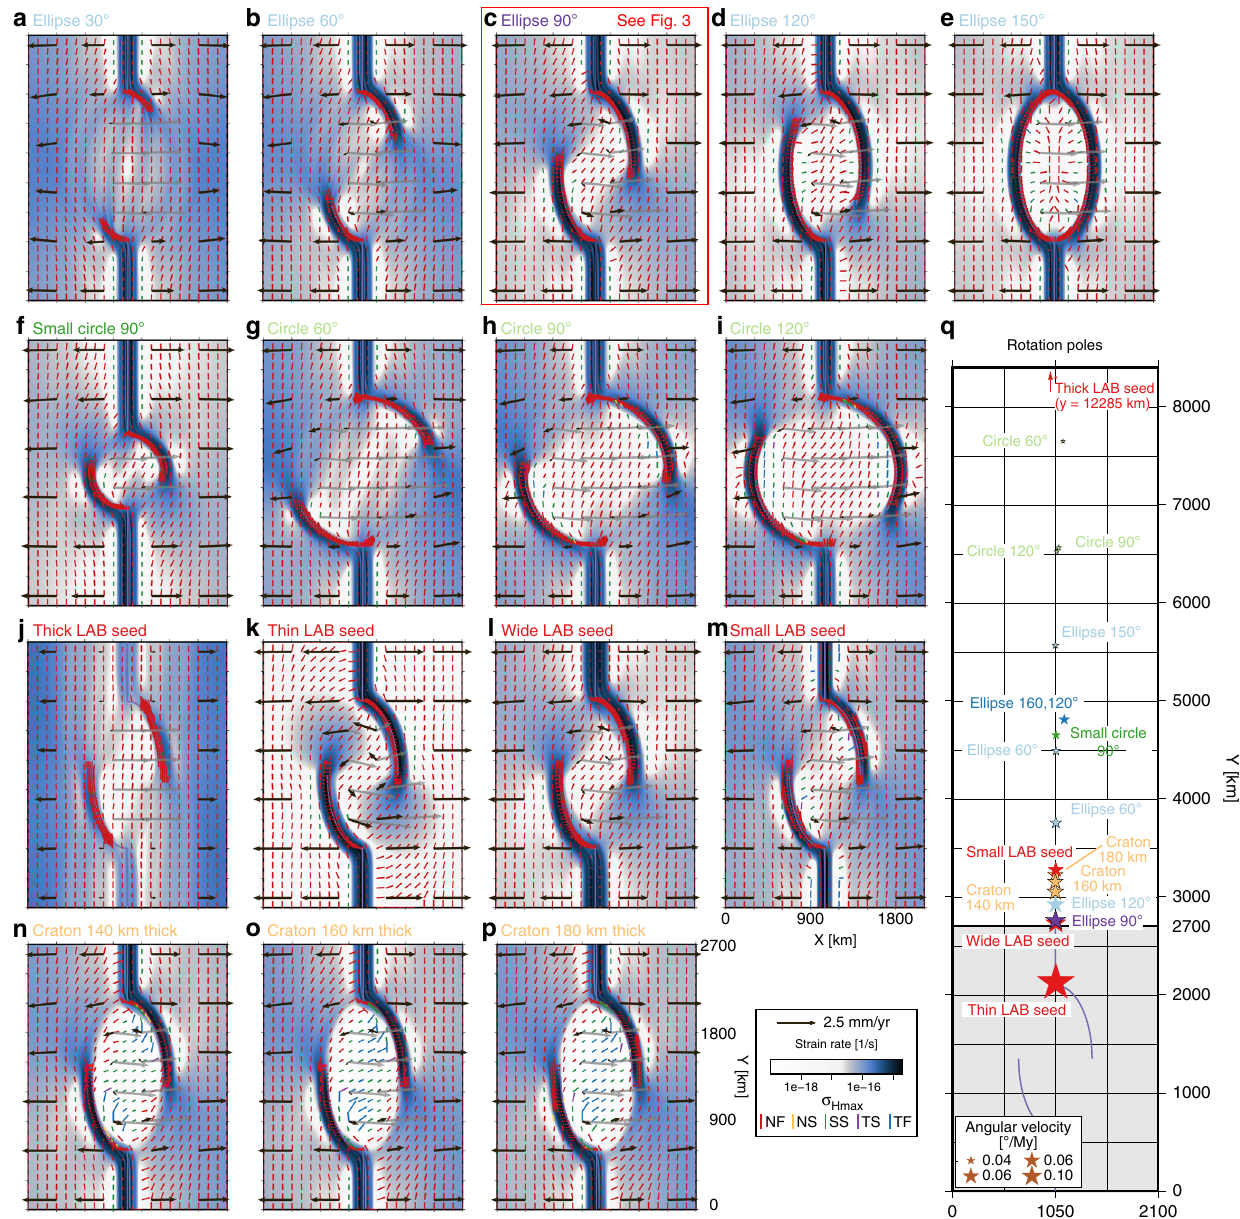
Fig. 4 Controlling factors of the generic mobile belt con fi guration model. Depicted are the strain rate fi eld, maximum horizontal compressive stress σ , and the velocity vectors at 3-km depth and 10 My for the generic models in a – p , together with the respective microplate rotation poles relative to the Hmax western plate in q . Black vectors in a – p are plotted in the model frame of motion, while the dark-gray vectors represent the microplate motion in a Nubia- fi xed frame. Black and gray vectors are scaled equally. A red box indicates the reference model detailed in Fig. 3. Details on each of the models are given in Table 1. NF normal faulting, NS normal and strike – slip faulting, SS strike – slip faulting, TS thrust and strike – slip faulting, TF thrust